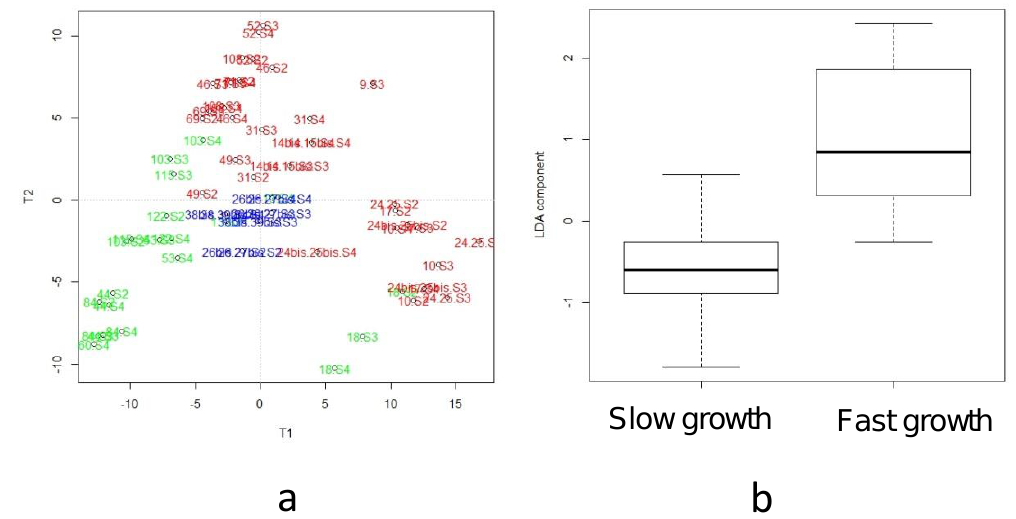
Figure 2. Analysis of Variance (AoV)-PLS and linear discriminant analysis (LDA) models based on the LC-ESI + -HRMS metabolomics profiles of human preterm milk on the factor weight Z -score (discharge-birth): AoV-PLS score plot with 56% of variance (R2Y = 34%) on components 1–2 ( a ) and LDA (built on components of AoV-PLS) with a p -value = 0) ( b ). Breast milk provided to preterm infants who experienced “faster” (green) or “slower” (red) growth and to twin infants with discordant growth rate, one twin with high growth rate and the other one with low growth rate, (blue).